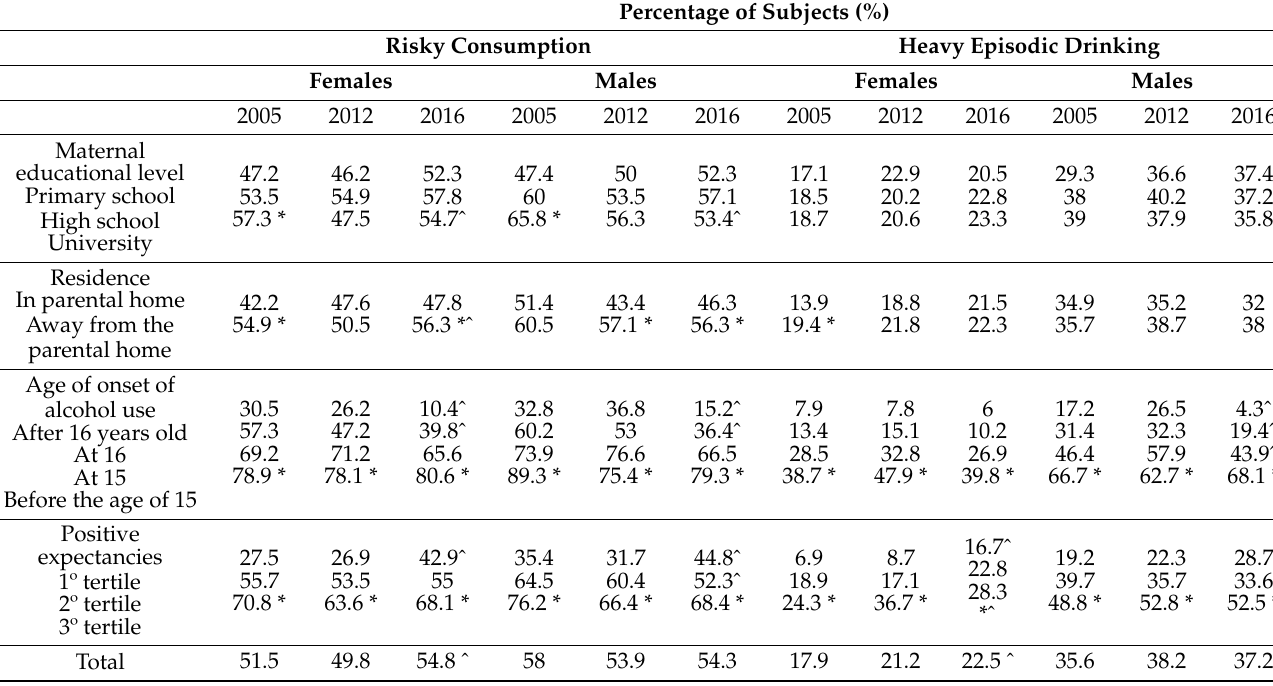
Table 2. Prevalence rates of risky consumption (RC) and heavy episodic drinking (HED) by maternal educational level, residence, and age of onset of use of alcohol, and positive expectancies. Percentage of Subjects